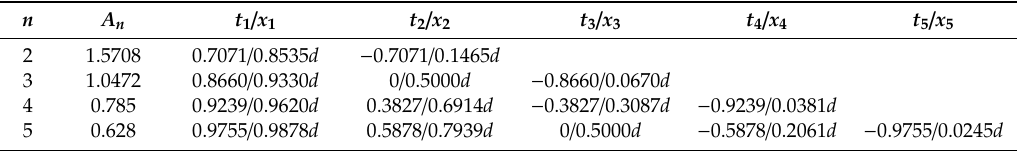
Table 1. Integral node information of Gauss–Chebyshev